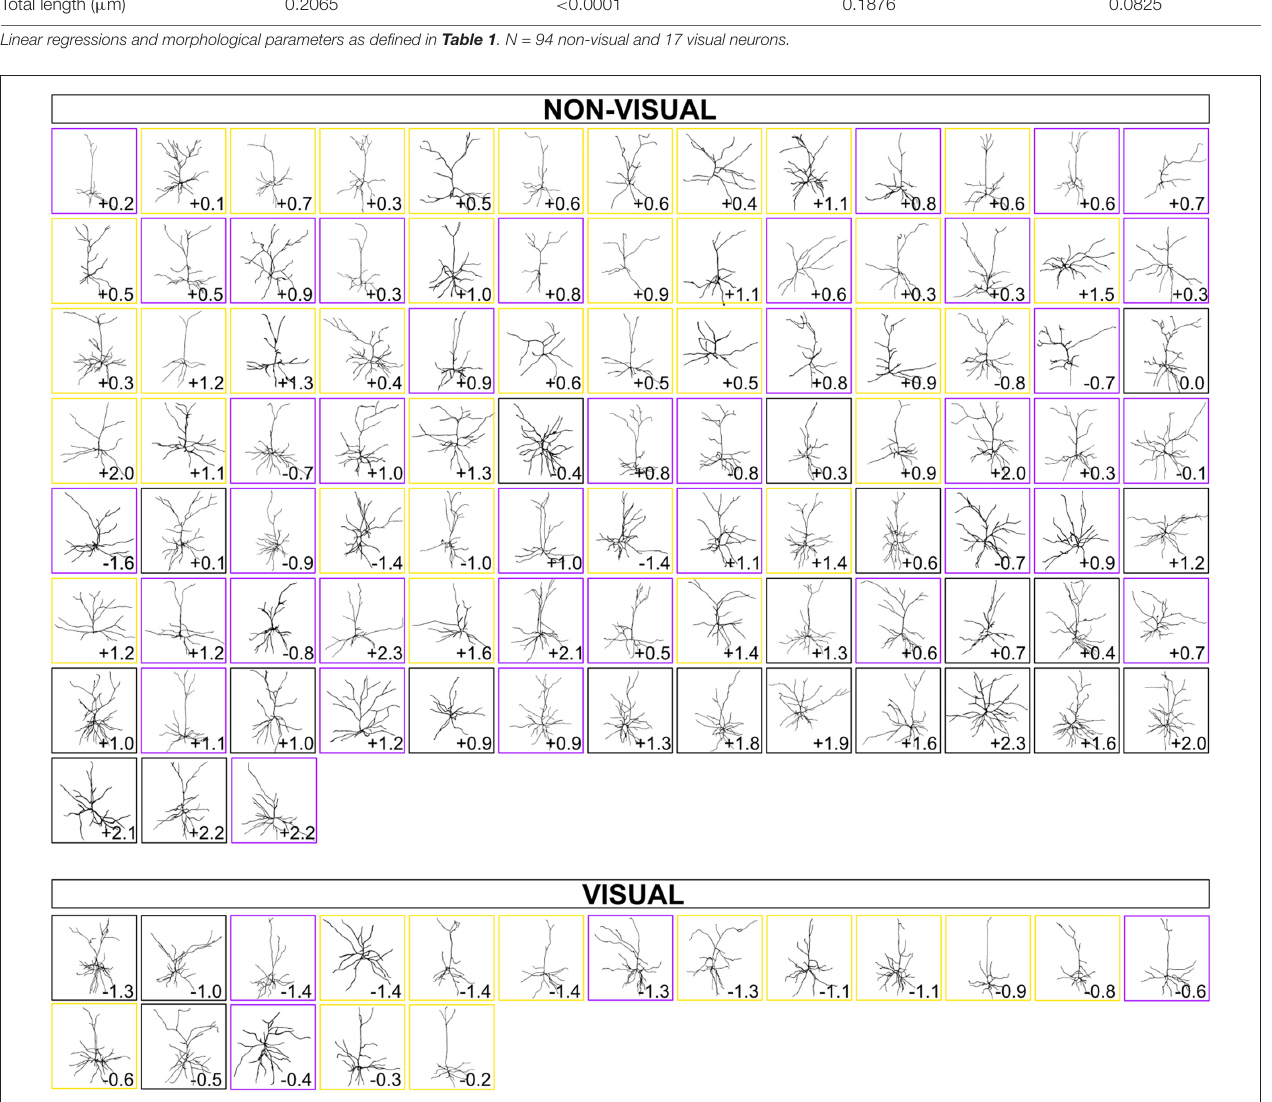
FIGURE 7 | Gallery of dendritic reconstructions, ordered by distance on optimized principal axes and divided into “non-visual” and “visual” zones. For each cortical zone, neurons presented in Figure 2 are now arranged from most caudomedial (top left) to most rostrolateral (bottom right) along the principal axes defined in Figure 6 (non-visual and visual). Neurons in boxes of the same color (black, purple, or gold) were taken from the same brain. Numbers, as in Figure 2 , still indicate rostrocaudal distance of each neuron’s section to the splenium of the corpus callosum (negative numbers are caudal to splenium, and positive numbers are rostral to